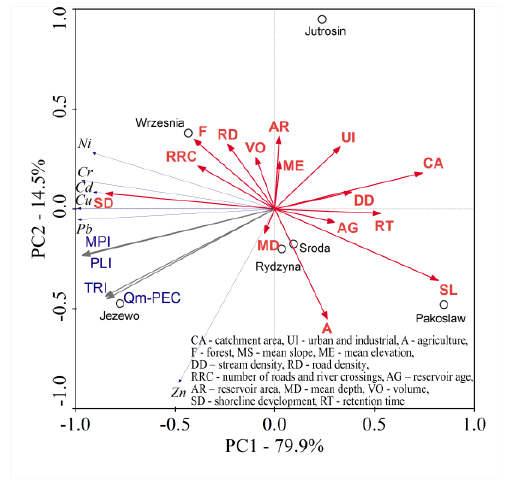
Figure 7. Identification of HM sources in bottom sediments of reservoirs.